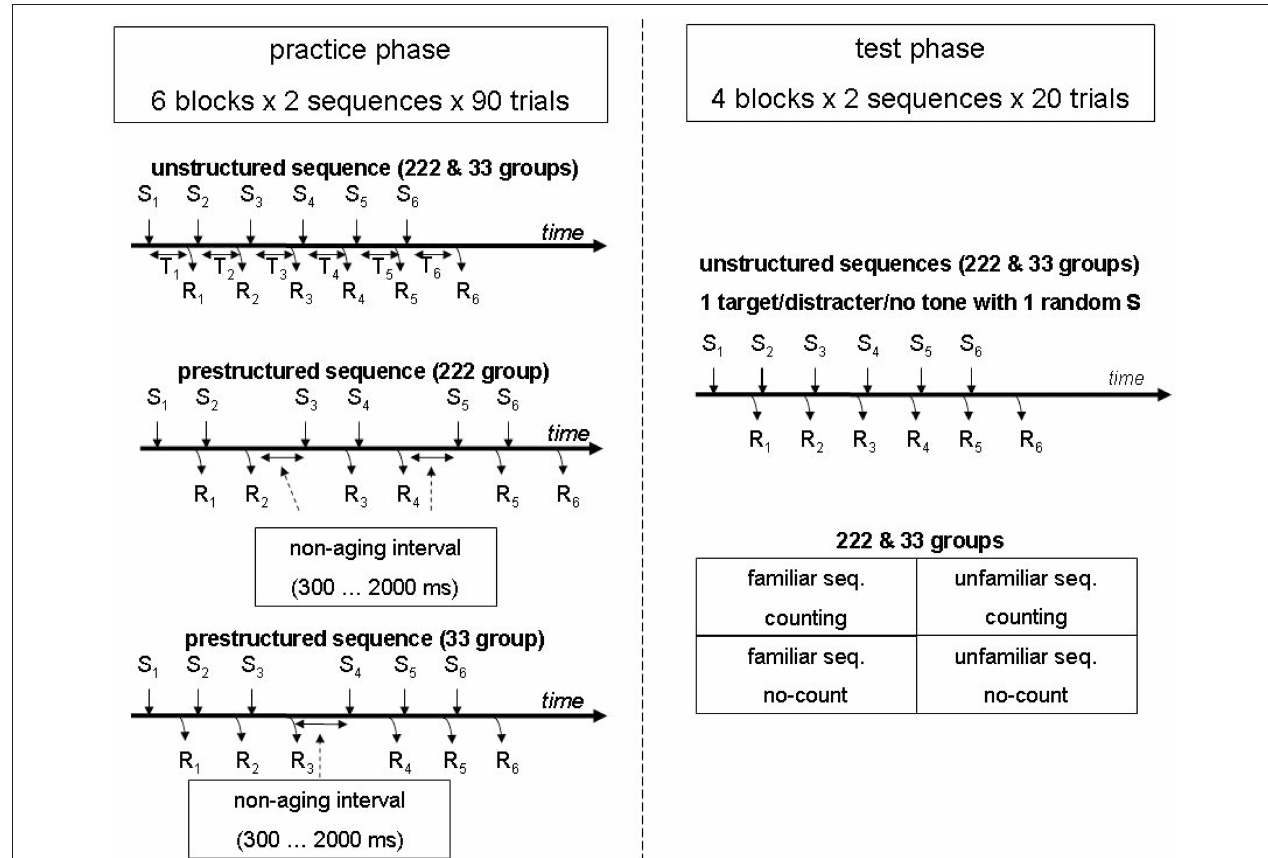
Figure 1 | Schematic representation of the experiment. The participants practiced one unstructured sequence as well as one prestructured sequence with either one (33 group) or two (222 group) non-aging (response stimulus) intervals (i.e., a pause). The test phase included for all participants the same two blocks with the two familiar and two blocks with two unfamiliar sequences.